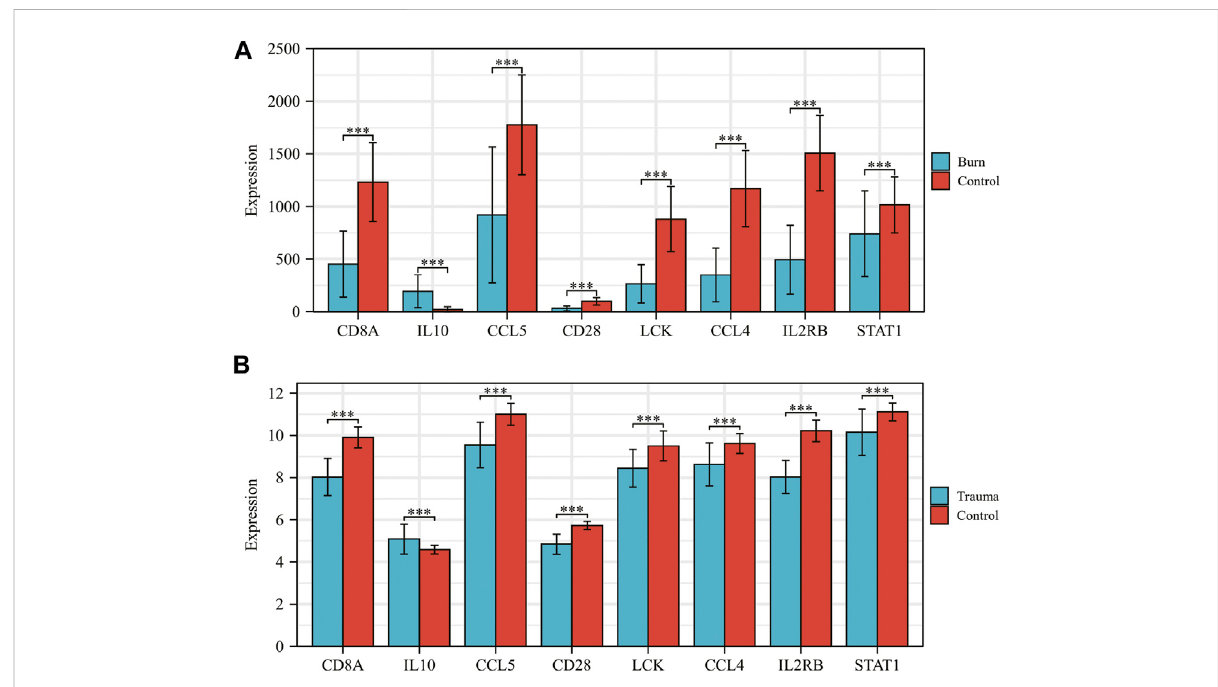
FIGURE 8 (A,B) Expression levels of core immune-related DEGs in GSE36809 and